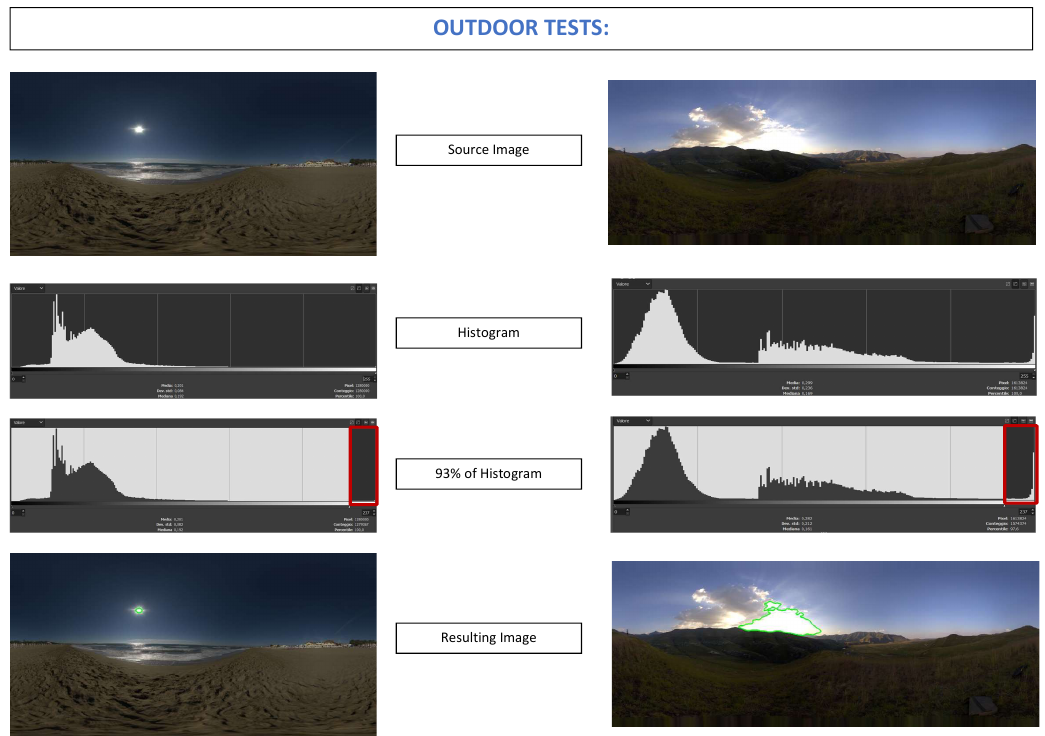
Figure 12. ARPAS on outdoor